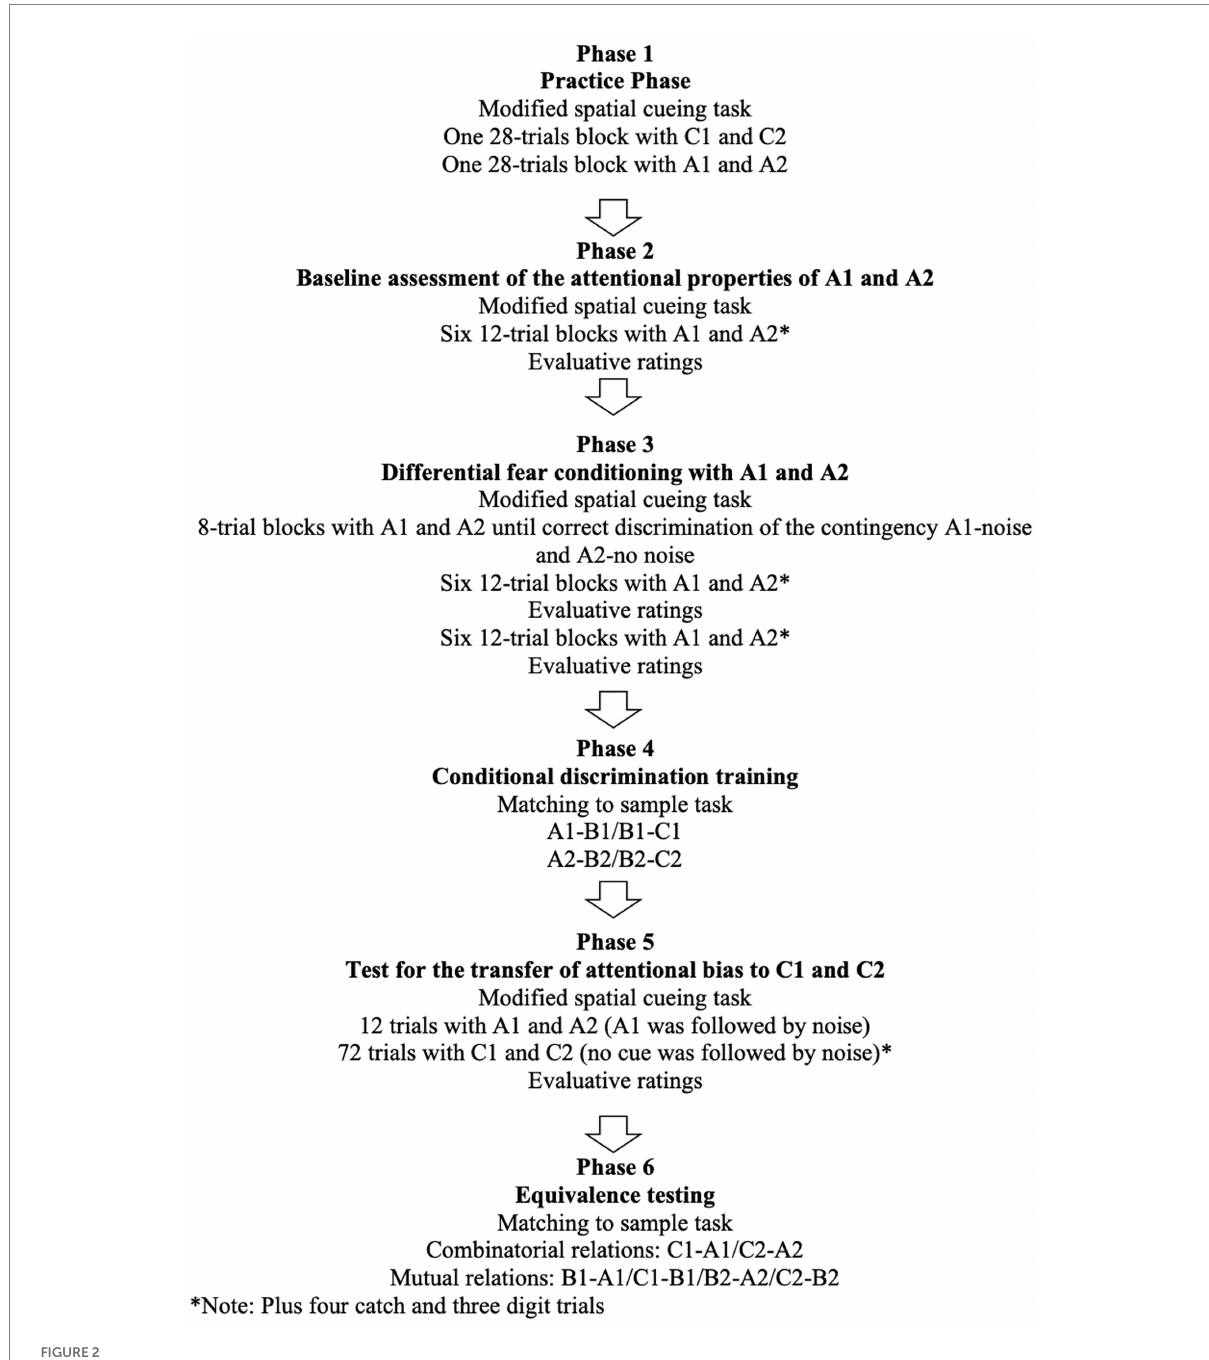
FIGURE 2 Schematic overview of the procedures